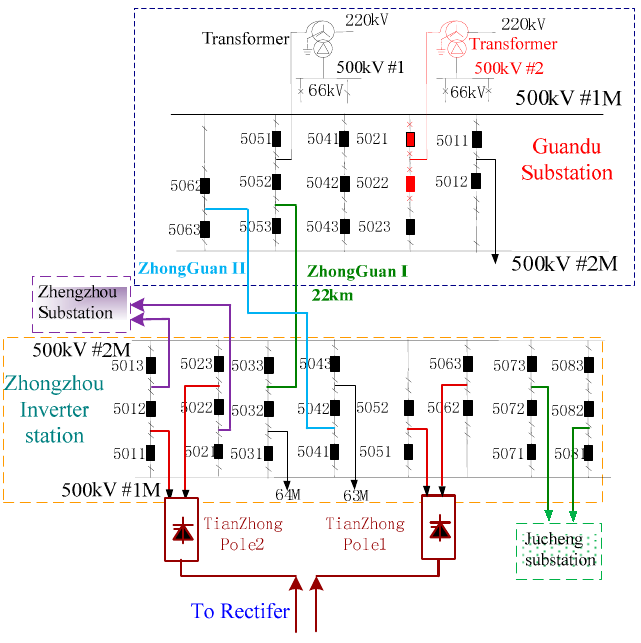
Figure 6. The wiring diagram of the AC/DC system.